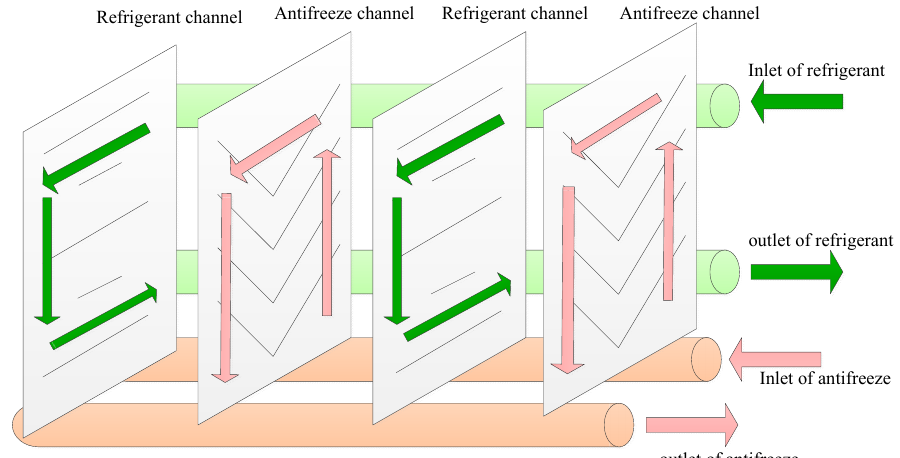
Figure 3. Principle of ARHEx.